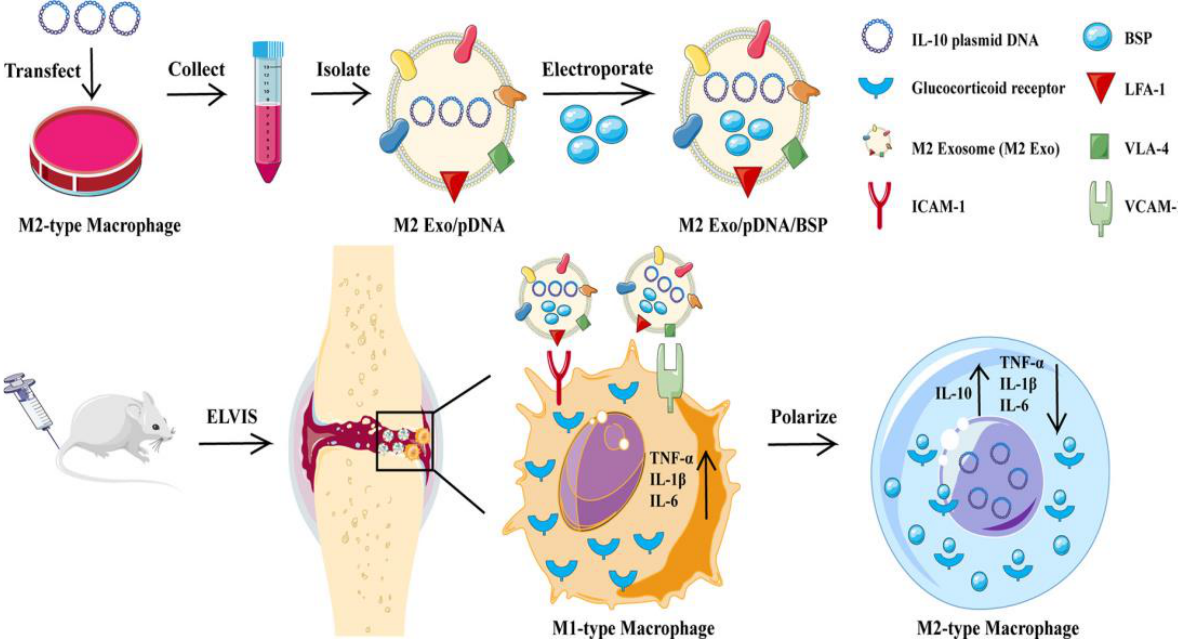
Figure 3. Schematic preparation, cellular uptake and mechanism of Exo/pDNA/BSP with the ability to regulate the polarization of macrophages. Reprinted with permission from Ref. [27]. Copyright © 2021 Published by Elsevier